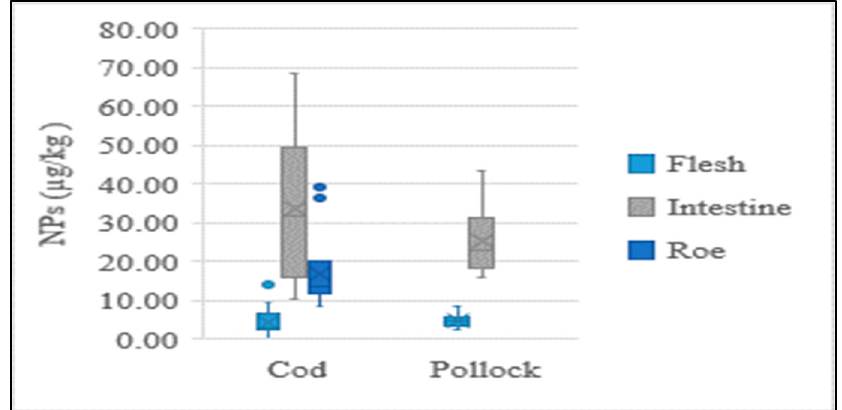
Figure 3. Average concentration of NPs in flesh, intestine, and roe of fish.